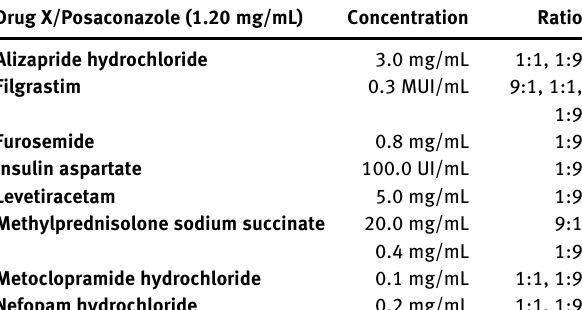
ganciclovir. After mixing posaconazole with pantoprazole, a precipitate was observed for the 9:1 ratio, a precipitate and a yellow colouring for 1:1 ratio are visual and for the 1:9 ratio, only a yellow colouring can be observed (Figure 2).